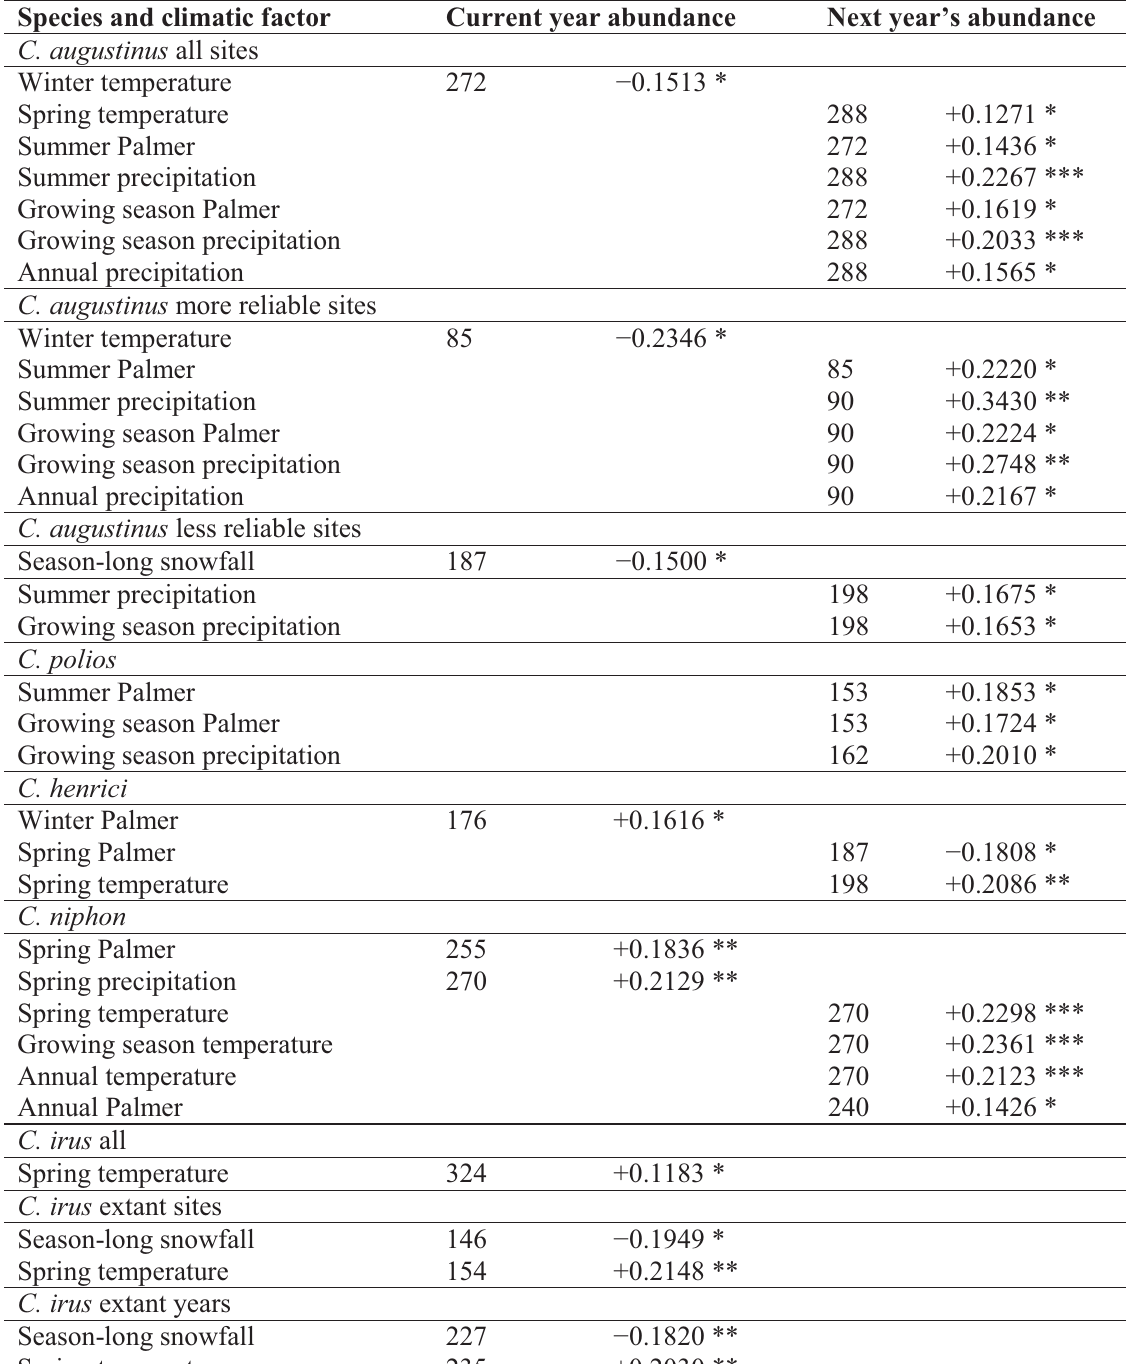
Table A1. Significant Spearman rank correlations of elfin abundance and climate variables, as summarized in Table 11. “ Palmer ” = Palmer Drought Severity Index (see Methods). * p < 0.05, ** p < 0.01, *** p <